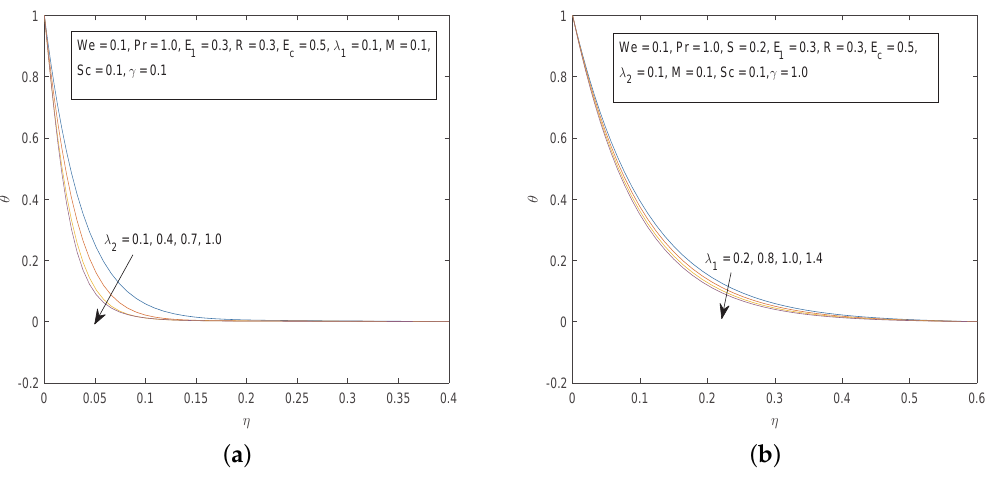
Figure 9. ( a ) Effects of λ 2 on θ and ( b ) Effects of λ 1 on θ .